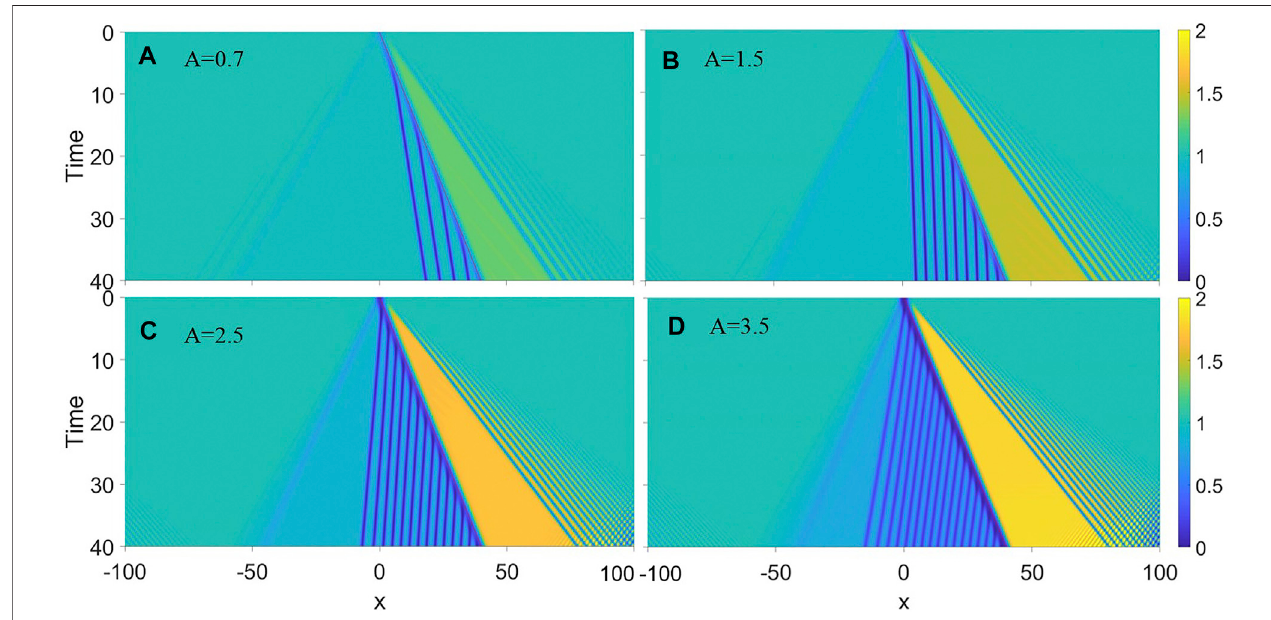
FIGURE1| SuccessiveemissionofdarksolitonsfromamovingGaussianobstacleat fi xedvelocity v (cid:2) 1withthenonlinearstrength g (cid:2) 2.Theobstacleheighttakes (A) A (cid:2) 0.7, (B) A (cid:2) 1.5, (C) A (cid:2) 2.5, (D) A (cid:2) 3.5, respectively. The color contour shows atom density. As the color is darker, the atom density is smaller. Thus, the deep blue parallel lines are dark solitonic trajectory. As the obstacle height increases, dark solitons are more frequently emitted.